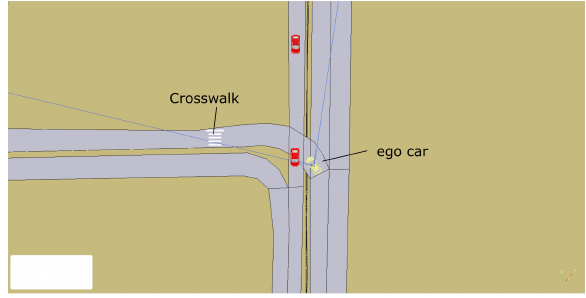
Figure 13. Stop scenario. Ego car in yellow has a STOP to turn to the left.